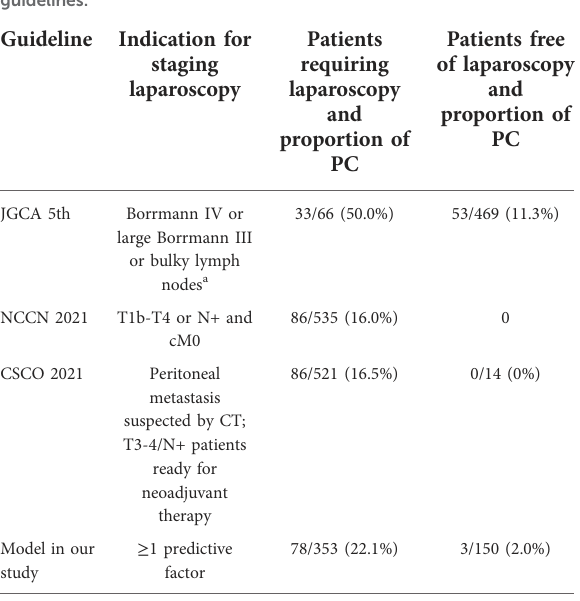
TABLE 4 Results of staging laparoscopy according to different